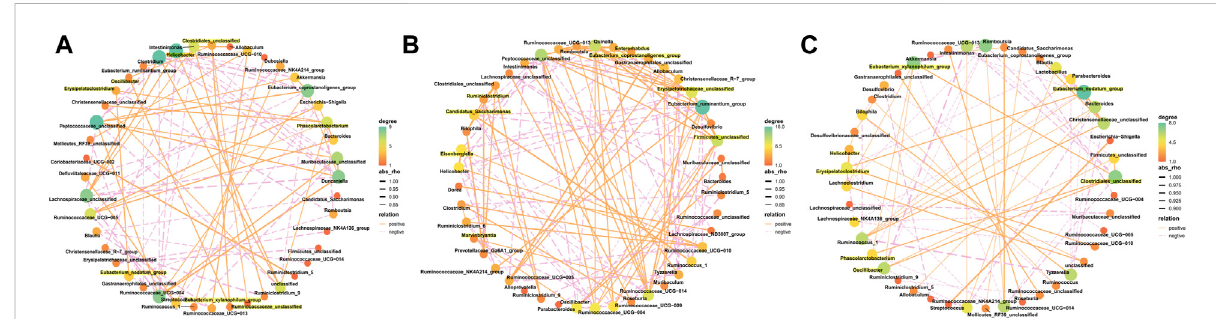
FIGURE 9 CorrelatednetworkofGMintheblankgroup (A) ,modelgroup (B) ,andSchgroup (C) .Signi fi cantstrongSpearmancorrelations( p ≤ 0.05,|rho| > 0.5) among the GM are presented in the network. The highlighting means that bacteria are emphasized in the results section. Color and size of the dots represent the center degree. The solid orange line represents positive correlation; the dotted pink line represents negative correlation. The thickness of the line represents the level of correlation, and the thicker line represents the greater correlation.